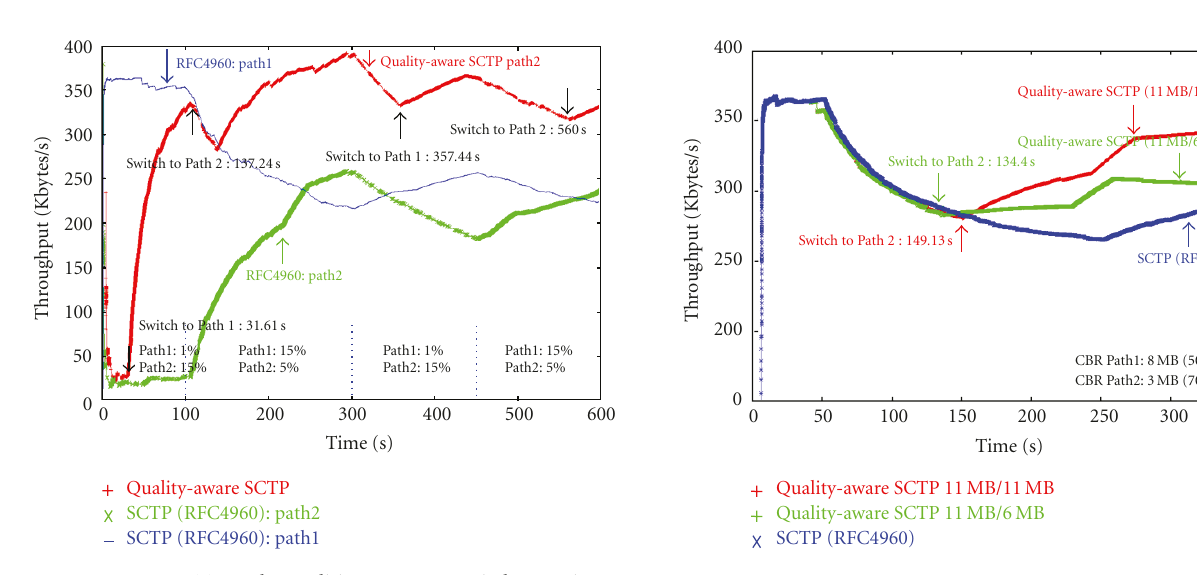
Figure 16: QA-SCTP path condition measure/switch experiment result.